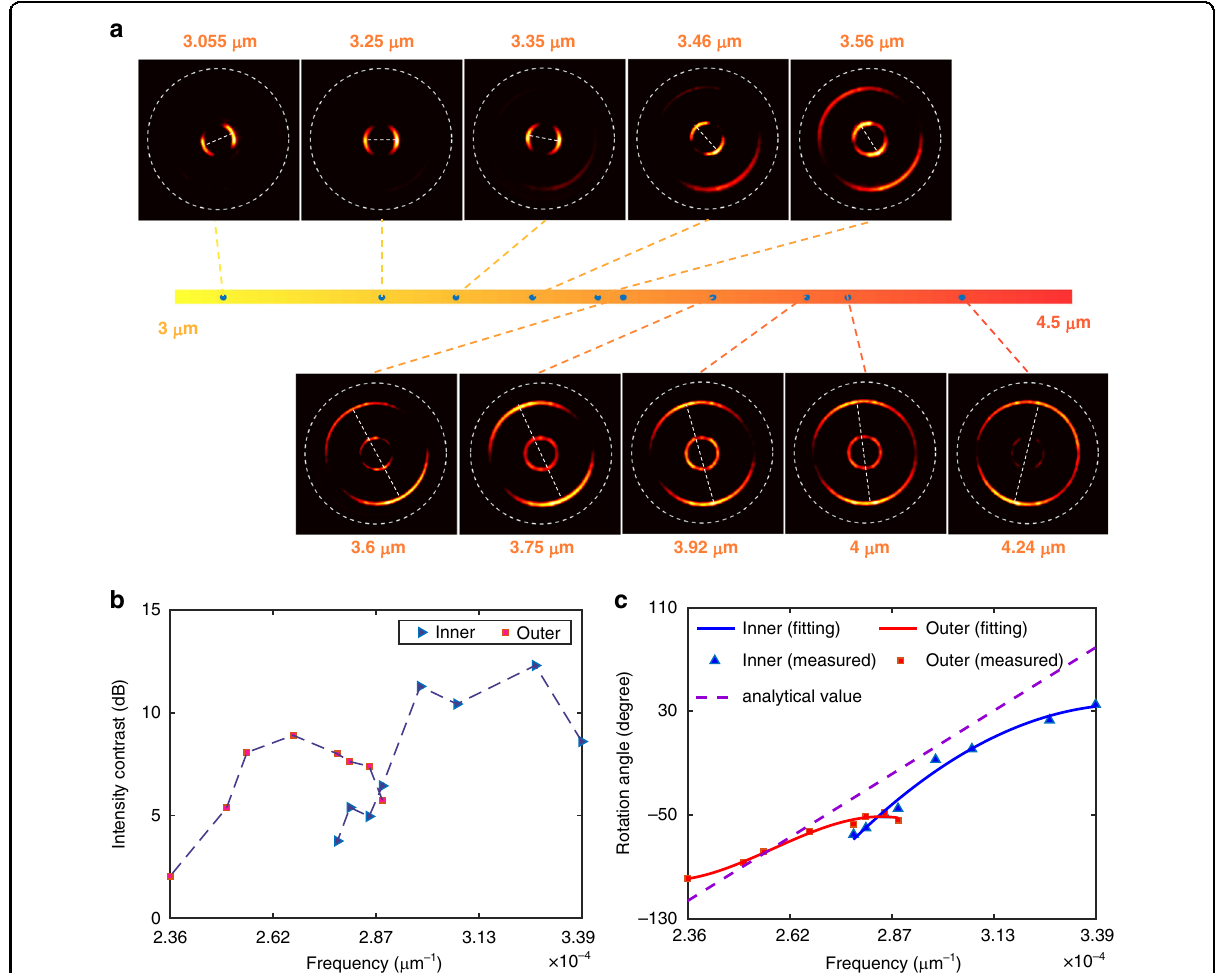
Fig. 5 Experimental results of the metadevice for wavelength extension. a The captured images on the same focal plane at different frequencies for left circular polarization incidence. The inner and outer rings are lightened with an incidence at wavelength bands of 3000 nm − 3600 nm and 3600 nm − 4300 nm, respectively. b Intensity contrasts of the measured results as a function of frequency for different operation bands. The values are on a logarithmic scale. c Relationship between the rotation angle of interfered spots and the incident frequency over two designed wavelength ranges. The dashed purple line represents the analytical